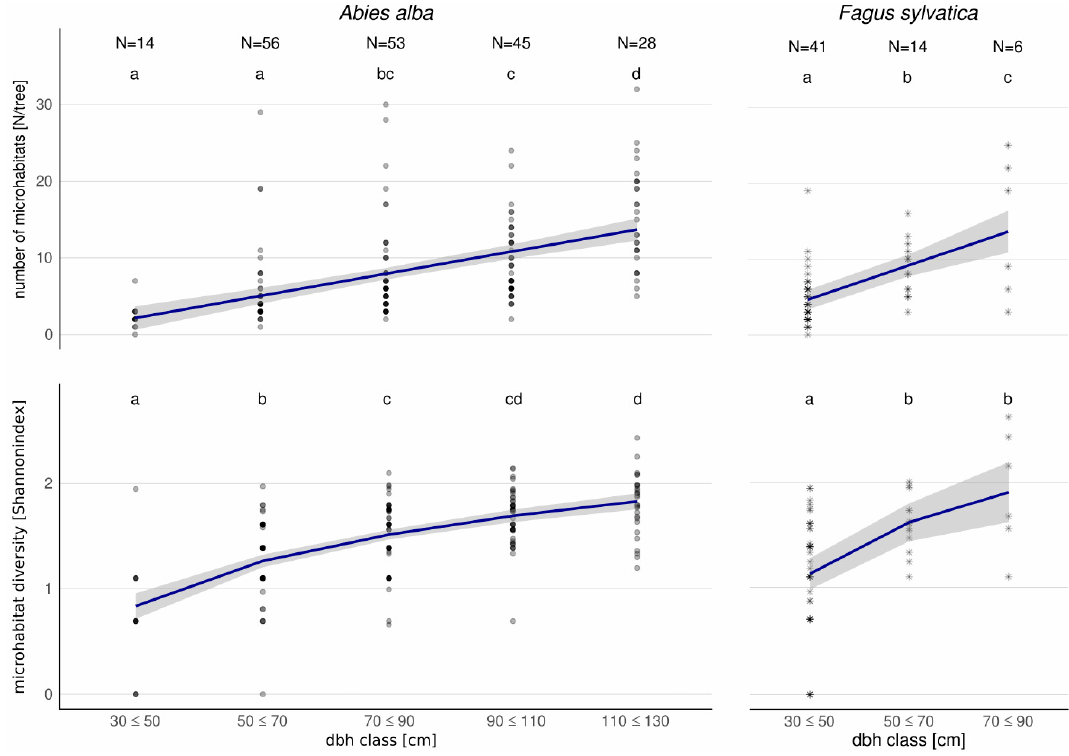
Figure 2. Number and diversity of microhabitats in habitat trees of the most frequent tree species Abies alba and Fagus sylvatica in relation to dbh classes. Different letters indicate significant differences between dbh classes. To facilitate the consideration of our findings in practical forestry, we used 20-cm-diameter classes instead of continuous dbh values.